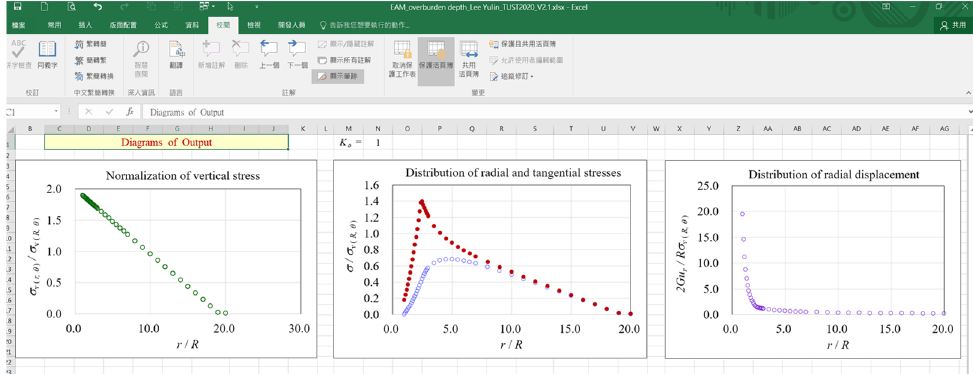
Figure 5. Drawing results presented by the Explicit Analysis Method (EAM).